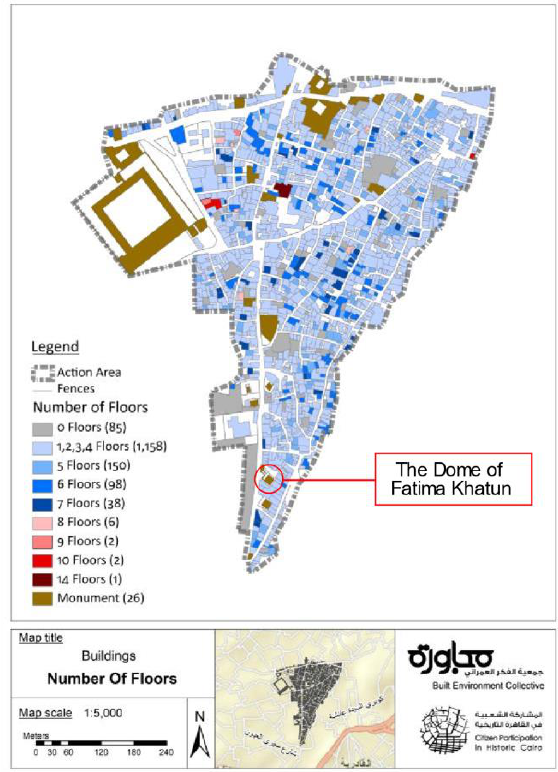
Figure 1. The location of the dome of Fatima Khatun at Al-Khalifa region (Reproduced with permission from MEGAWRA-BEC, unpublished report, 2017 [39]).